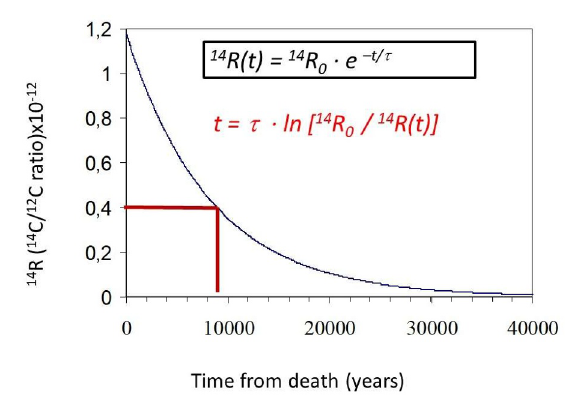
Fig. 3. 14 C is used as a natural chronometer to date organic materials, those systems that have been directly (or indirectly) in equilibrium with the atmosphere, acquiring 14 C from it, and that have ceased that equilibrium condition at a well-defined